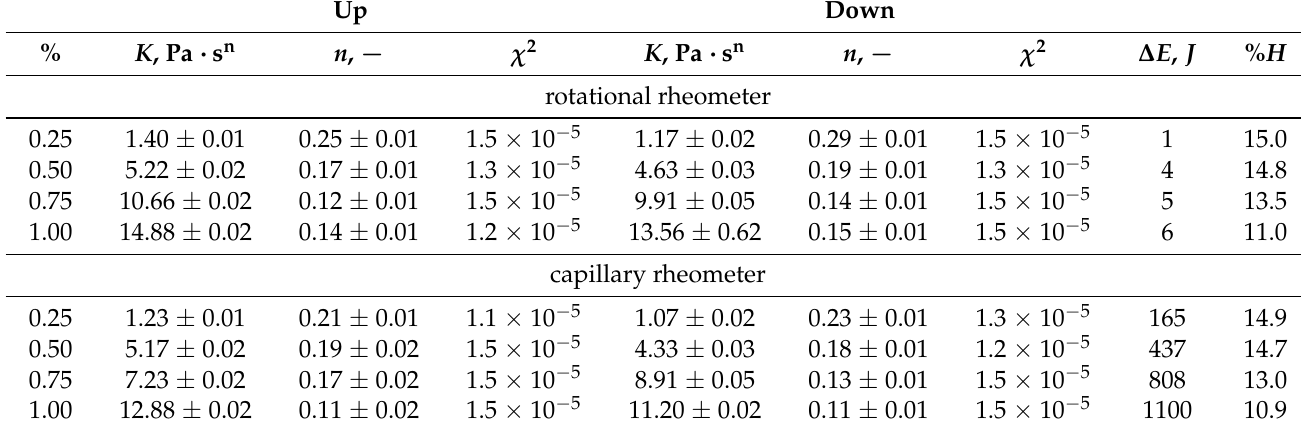
Table 1. Comparison of the parameters of the Herschel-Bulkley rheological model Equation (4) determined on the basis of the results of measurements with rotational and capillary-pipe viscometers for selected food systems and value of Chi-square function Equation